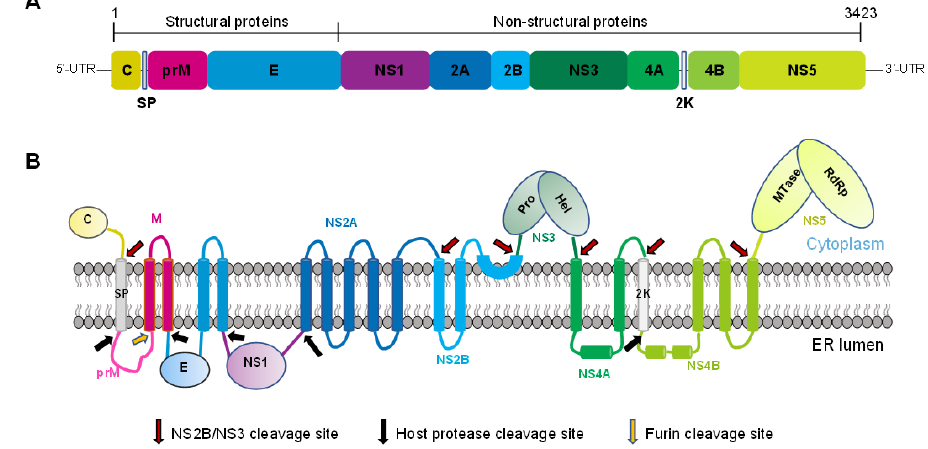
Figure 1. Schematic diagram of ZIKV polyprotein organization and processing. ( A ) Linear organization of the ZIKV polyprotein precursor, including the three structural and seven nonstructural proteins. ( B ) Topology of the polyprotein in the ER membrane and its sites of splicing by the host or viral proteases.